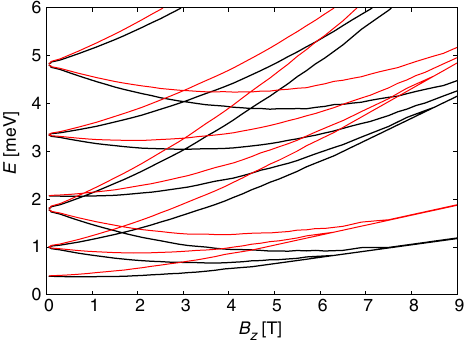
FIG. 5 Spectrum of a 40 nm WS 2 QD as a function of the perpendicular magnetic field B spin ↑ ( ↓ ) states from valley K ( K 0 ). The values of m τ ;s found in Table I, whereas g